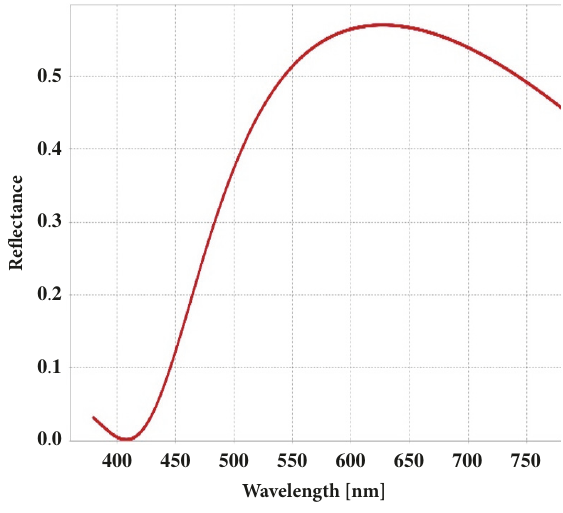
Figure 19: Reflectance of DBR structure.